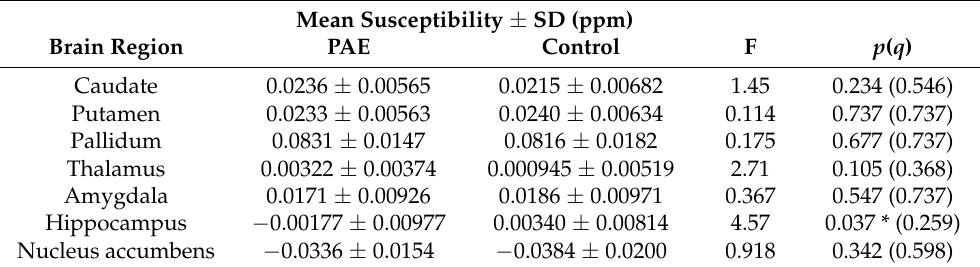
Table 2. Group differences in susceptibility between PAE and unexposed control participants by region of